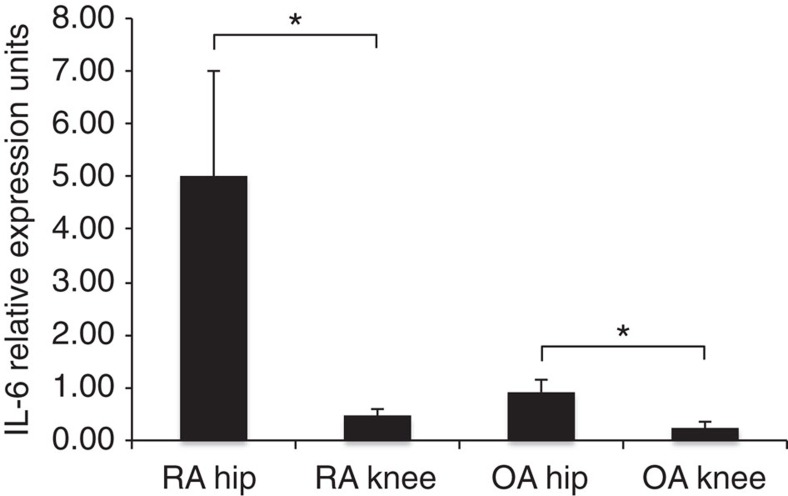
Synovial IL-6 expression levels using quantitative PCR.Intact synovial tissue was processed as described in the Methods and evaluated for IL-6 mRNA transcripts. Note that IL-6 gene expression is higher in RA than OA, and within-disease, higher in hip than knee. *P-values<0.05, calculated by two-tailed unpaired t-test with Welch's correction (n=13 RA hip, 22 RA knee, 13 OA hip, 15 OA knee). Data presented as mean±s.e.m. (see the Methods for details).